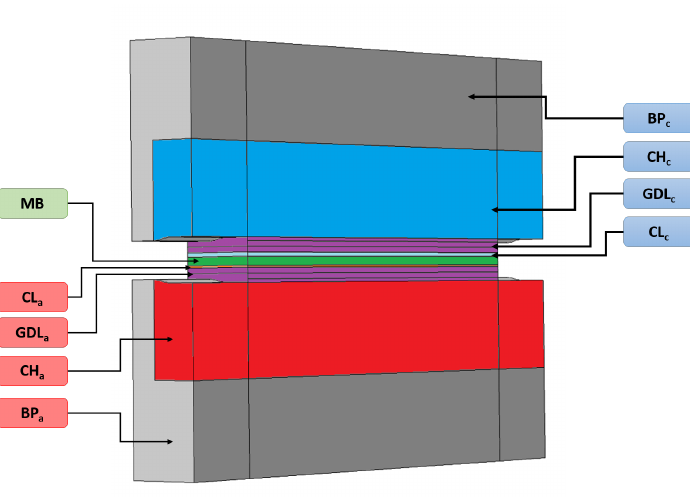
Figure 1. 3D geometrical view of the model, integrating bipolar plate (BP), channels (CH), gas diffusion layers (GDL), catalyst layers (CL), and membrane